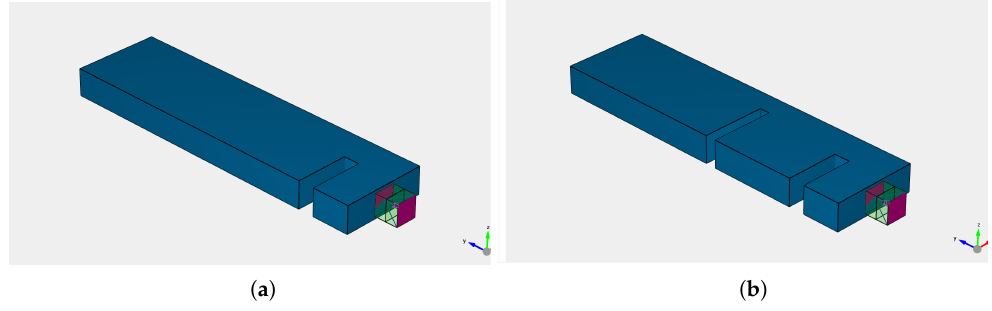
Figure 2. Objects with cracks: ( a ) one crack; ( b ) two